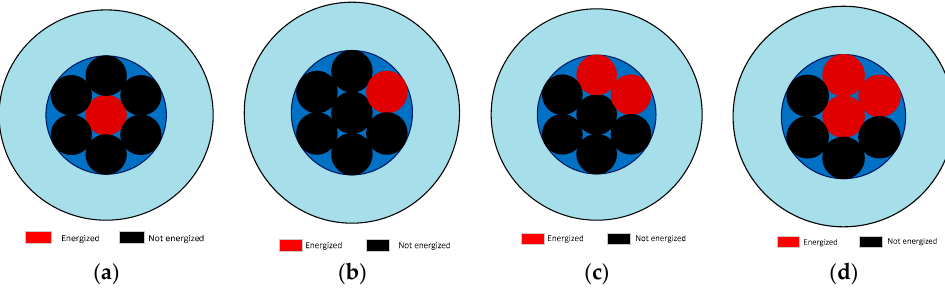
Figure 10. Structure of the insulation eccentricity cables: ( a ) normal, ( b ) case 1, ( c ) case 2, ( d ) case 3.